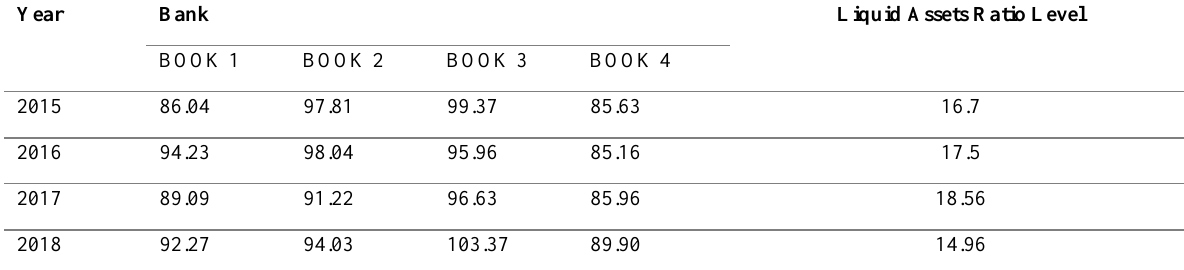
Table 1: Loan to deposit (LDR) level and conventional bank liquid assets ratio